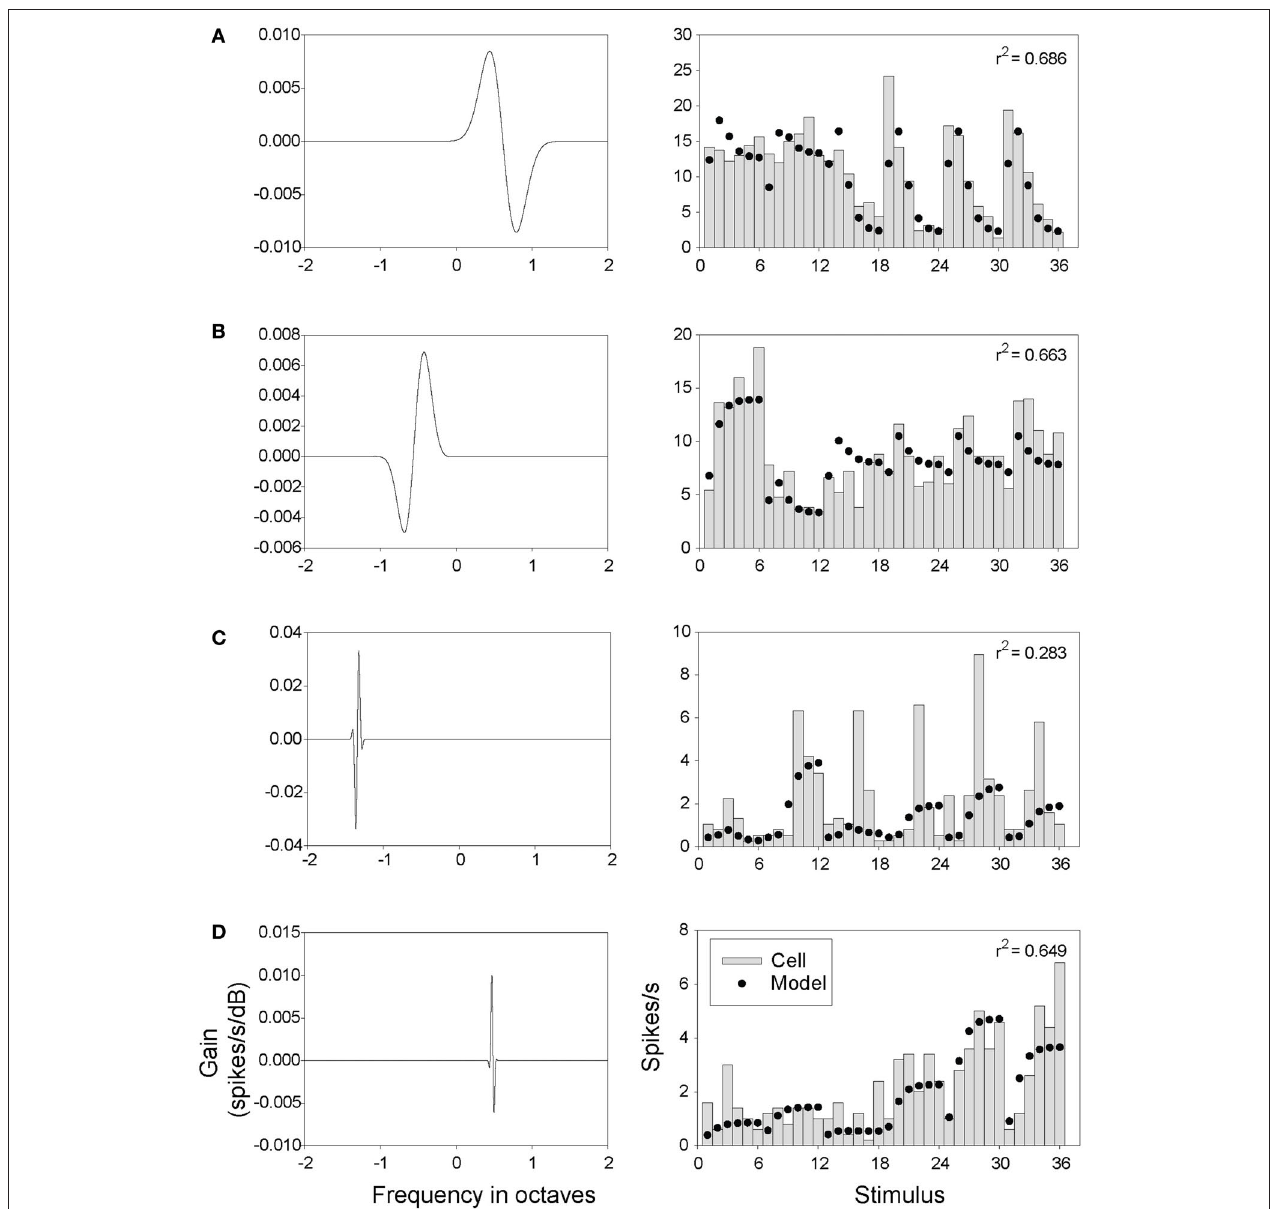
FiGure 10 | Gabor model filters and outputs. Each row represents the results from a single neuron ( A–d , left column ). Each plot depicts a Gabor filter (weight vector) obtained for a single neuron using the optimization procedure used with Eq. 1 and the Gabor function as described in Section “Materials and Methods”. The